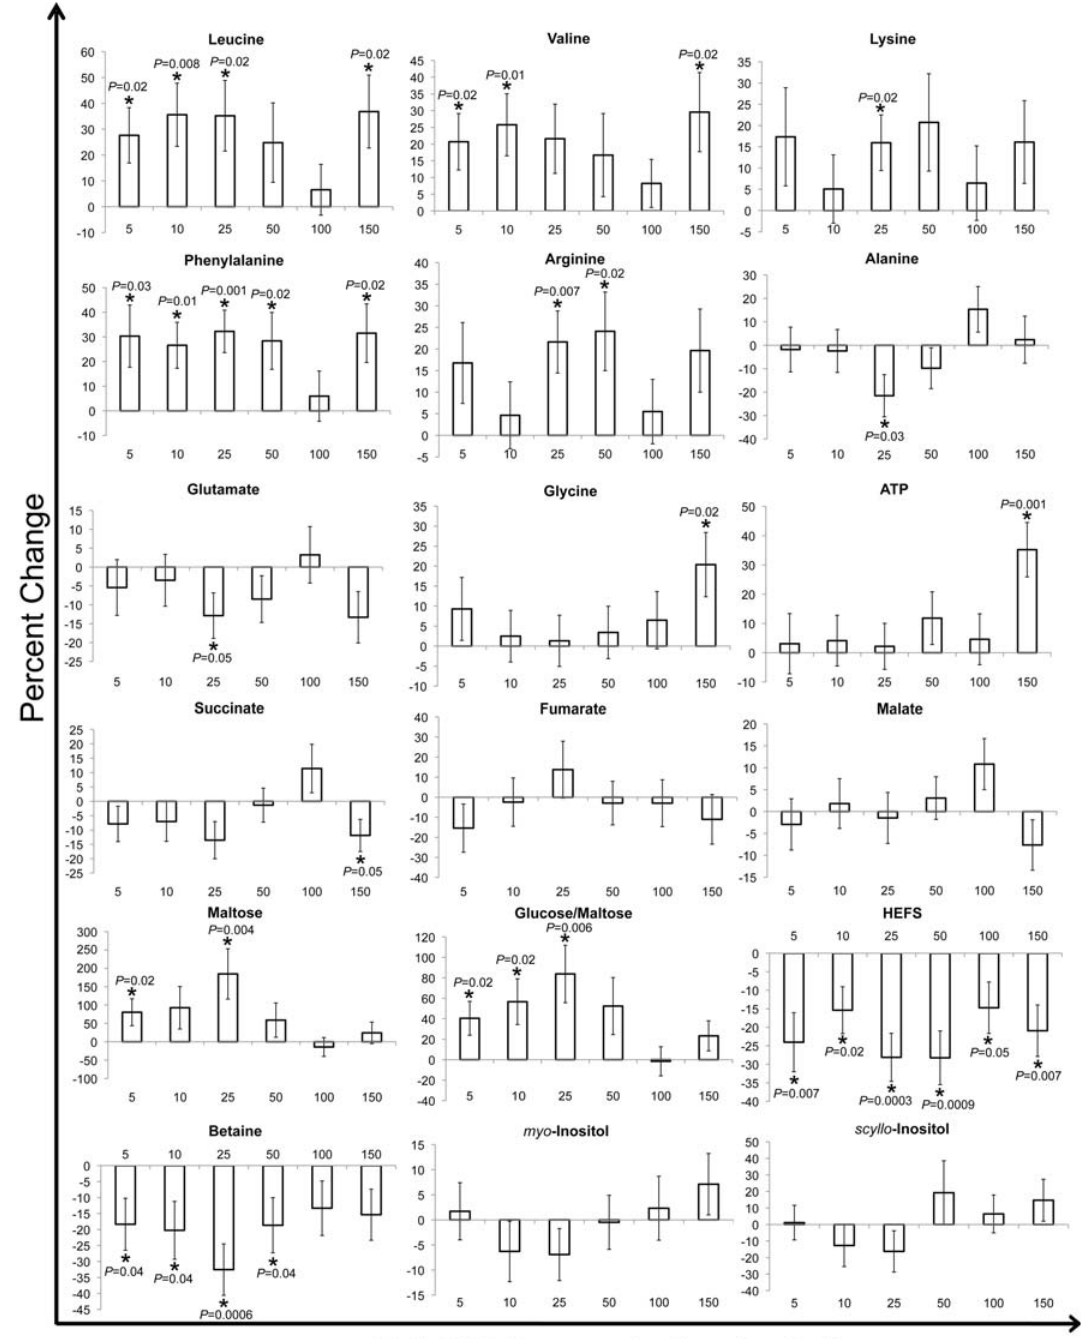
Figure 4. Percent (%) change in selected metabolites of two-day PFOS exposed tissue extracts compared with the control earthworms. The % changes in the intensity of Eisenia fetida metabolite resonances of exposed earthworms relative to the controls were obtained by first subtracting the buckets that pertain to the metabolites in the control earthworms from the exposed earthworms for each exposure concentration and then dividing again by the buckets in the control earthworms [43]. The percent changes that were significantly (at α = 0.05) different from the control (based on a t -test (two tailed, equal variances) of control vs. exposed) are labeled with an asterisk (*) and also show the corresponding p -values. The percent changes are shown with their associated standard